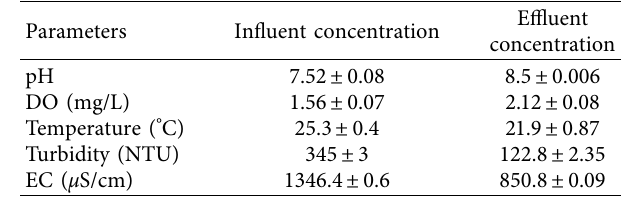
Table 2: Mean ± SD of physical parameters of WSP system in